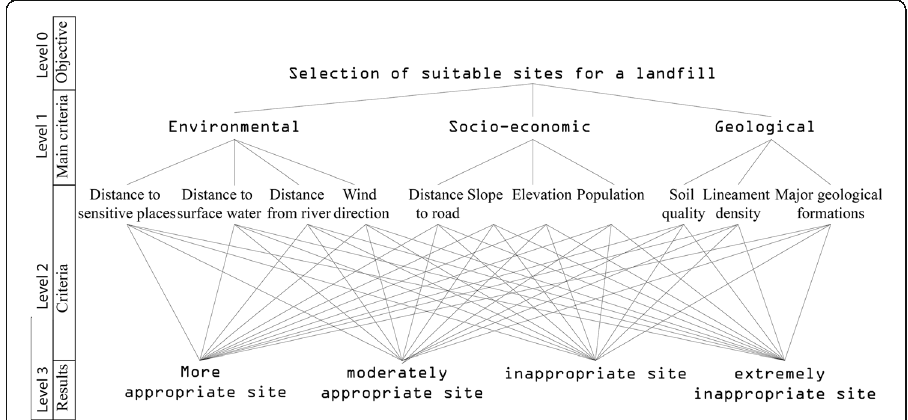
Fig. 9 Hierarchy structure for the landfill site